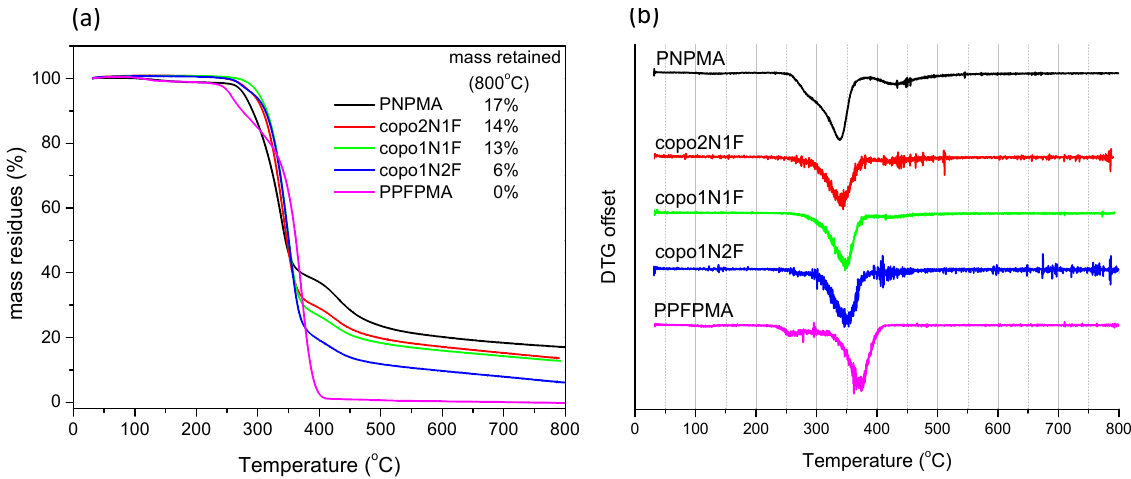
Figure 6. ( a ) TGA profiles and ( b ) DTG profiles of PPFPMA, PNPMA, and copolymers at different compositions (68 h of polymerization) and their mass residues retained at 800 °C.